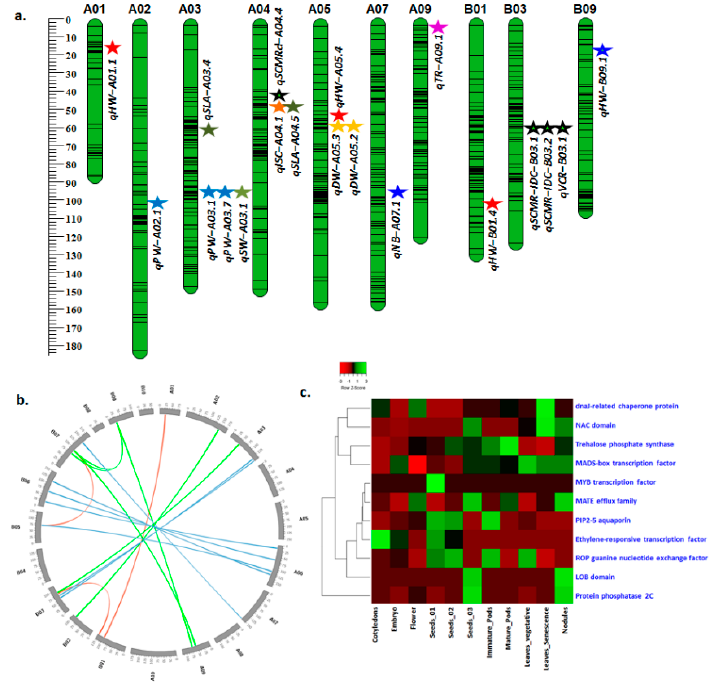
Figure 3. Genomic positions of major main-effect and epistatic-effect QTLs and expression of candidate genes detected in these QTL regions. ( a ) Genomic positions of major effect QTLs for drought tolerance- and iron deficiency (ID) tolerance-related traits on map chart with chromosome number and genetic positions. ( b ) Major epistatic interactions identified for the traits, namely VCR, SCMR, and haulm weight. Circos plot depicts 20 A. hypogaea chromosomes and interaction between the genomic regions of these chromosomes. Most of the major epistatic interactions were found in the genomic regions of homologous chromosomes of both sub-genomes A. ipaensis and A. duranensis. Outer track represents 20 pseudomolecules of groundnut in gray color. Inner lines of three different colors (red—VCR, green—haulm weight, and blue—SCMR) represents the epistatic interactions between genomic regions of 20 pseudomolecules of groundnut. ( c )Tissue-specific expression of candidate genes identified in QTL regions of SCMR, VCR, pod weight, and haulm weight. Expression of candidate genes was studied using A. hypogaea gene expression atlas [36]. The expression of 11 candidate genes in 11 tissues (Cotyledons, Embryo, Flower, Seeds_01, Seeds_02, Seeds_03, Immature_Pods, Mature_Pods, Leaves_vegetative, Leaves_Senescence and, Nodules) is plotted in the heatmap.